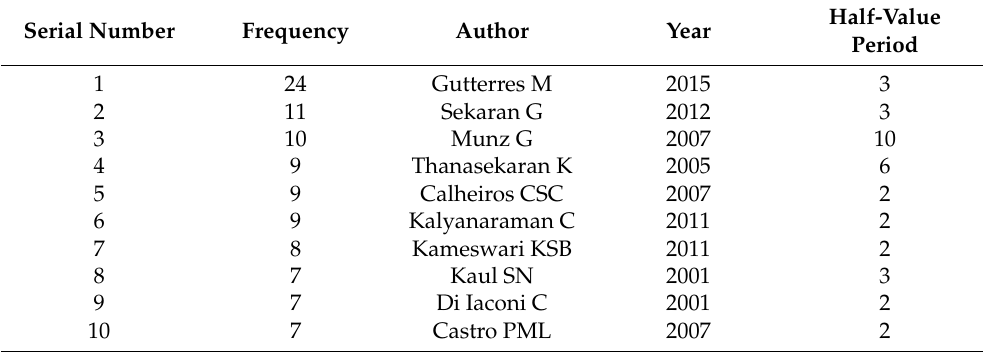
Figure 5. Authors and their cooperation relationship in tannery wastewater research. Scholarly collaboration can help research progress. For example, the contributions of diverse students can lead to a better understanding of a particular research area. The analytical field “author” was used to import the data into the software. A two-year time slice (time slice = 2) and a threshold value of n = 50 were used to determine the time period from 1991 to 2022. Tannery wastewater research collaboration between authors from 1991 to 2022. Table 4. Top 10 productive authors in tannery wastewater research. This list summarizes the ten most prolific writers in the field of tannery wastewater research from 1991 to 2022. Gutterres M is on top of the list, followed by Sekaran G.